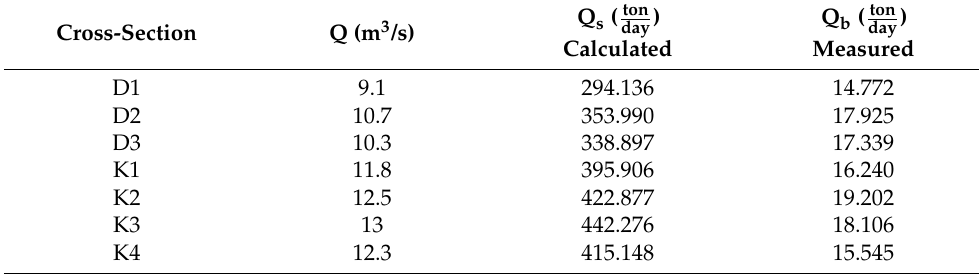
Table 13. Flow and sediment discharge at all cross-sections.